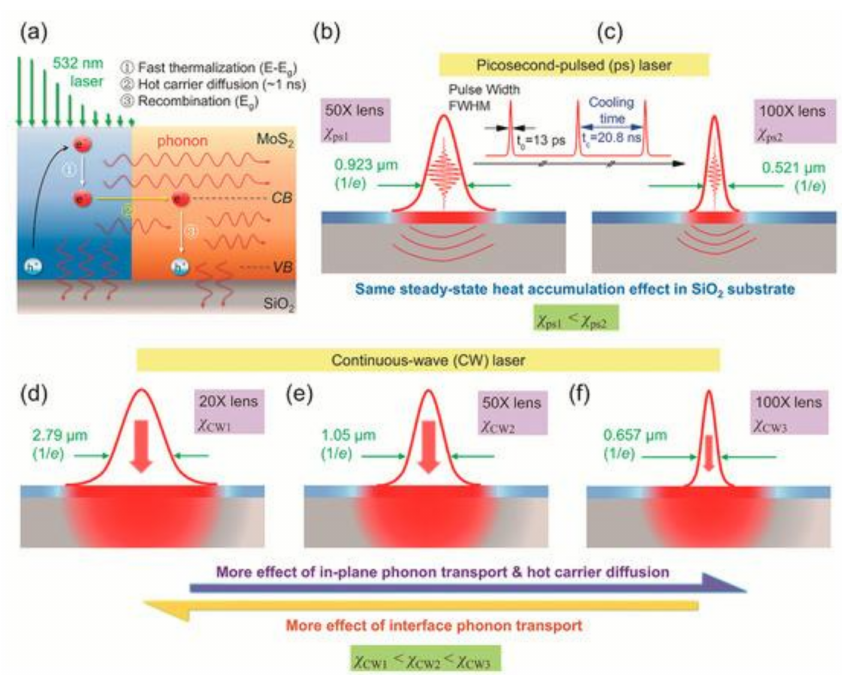
Figure 8. The Schematic diagram for mechanism of five-state energy transport state-resolved Raman (ET-Raman) technique. ( a ) The generation, diffusion, and recombination of the hot carrier in MoS 2 upon laser irradiating. ( b , c ) Transient state heating using picosecond laser heating under 50 × and 100 × objective lenses. ( d – f ) Steady state heating using CW laser with 20 × , 50 × , and 100 × objective lenses. Reproduced from Ref. [51] with permission from the Royal Society of Chemistry. Copyright 2018, Royal Society of Chemistry.